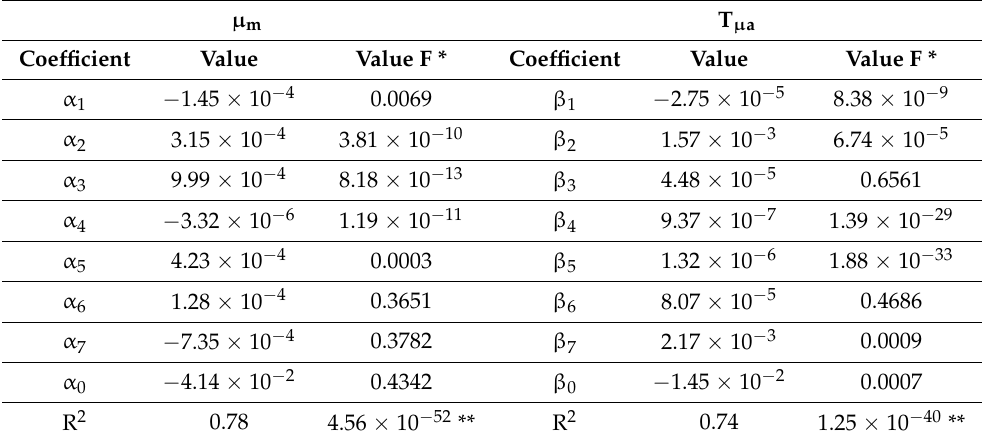
Table 8. Regression function coefficients with R 2 fitting for µ m and T µ a models before verification.